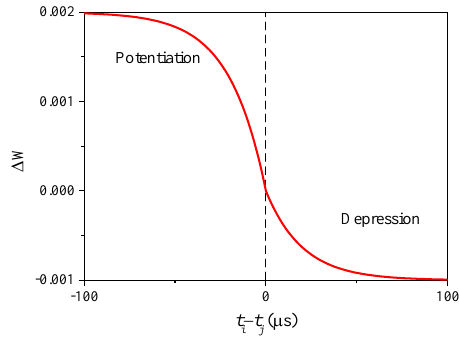
Figure 2. STDP rule used in the proposed